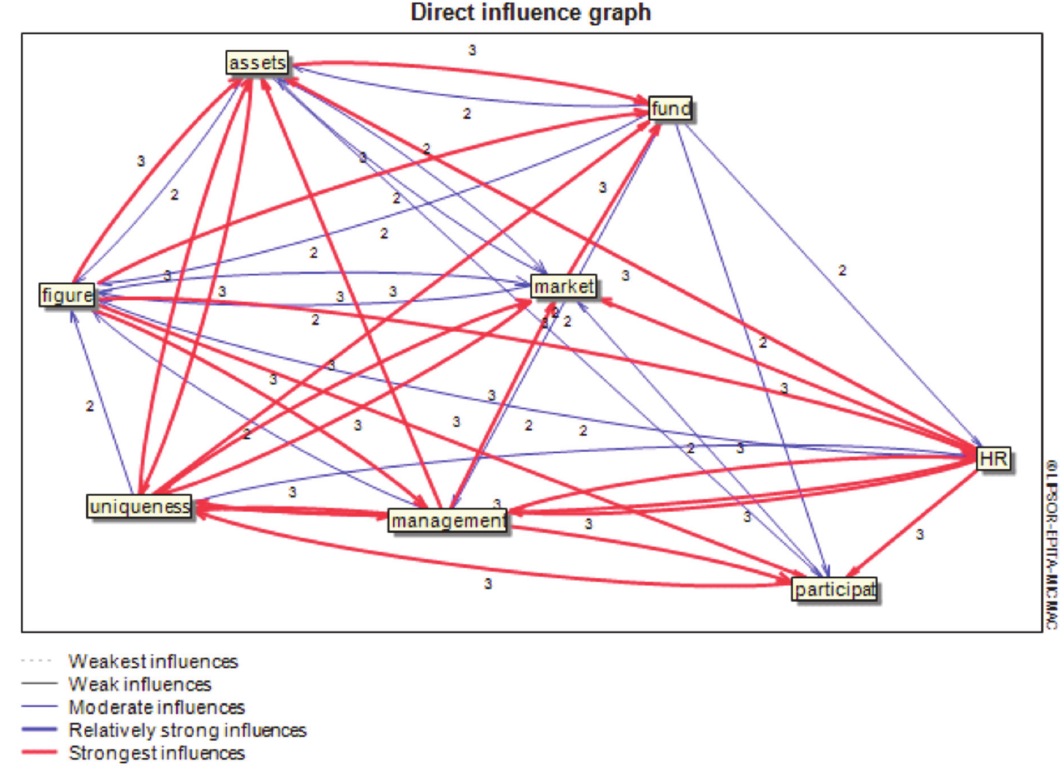
Fig. 5. Relationship among Direct Influence of Sustainability